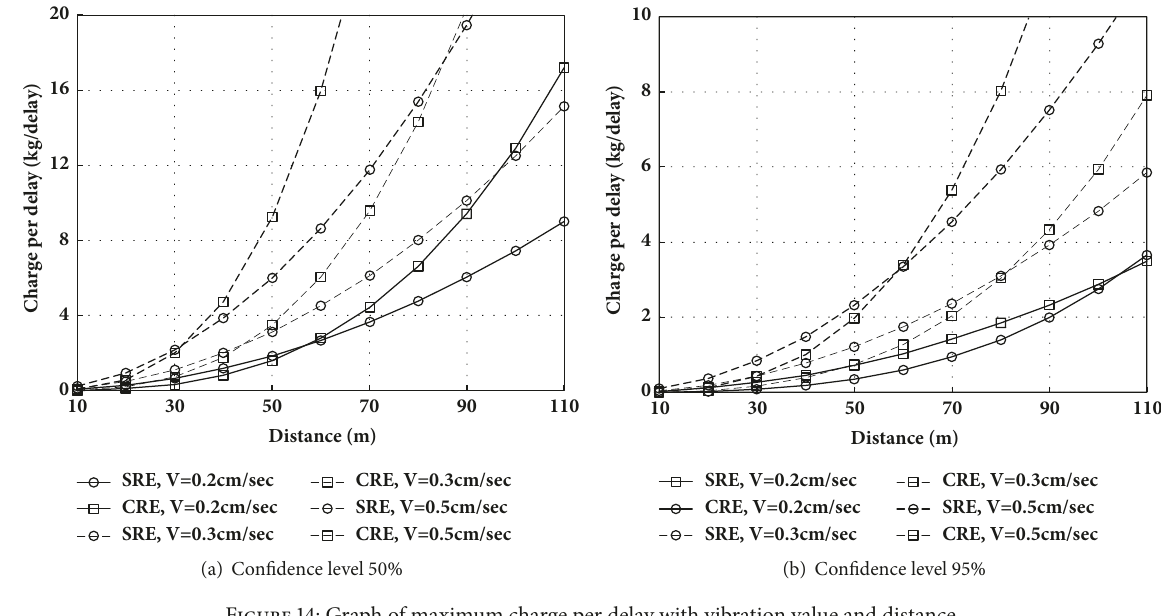
Figure 14: Graph of maximum charge per delay with vibration value and distance. Table 5: Comparison among noise levels obtained from test blasting and several equations for noise prediction. Method for obtaining noise level